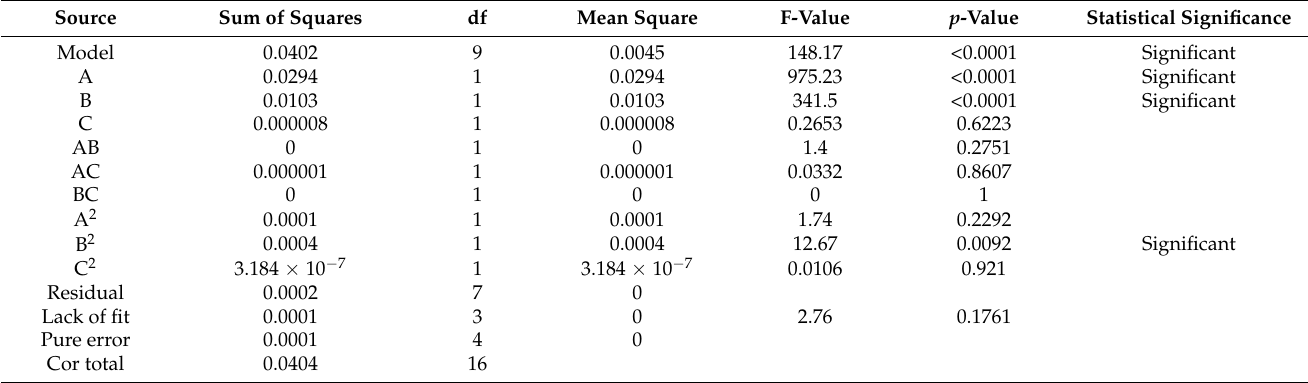
Table 5. Significance analysis of response surface.